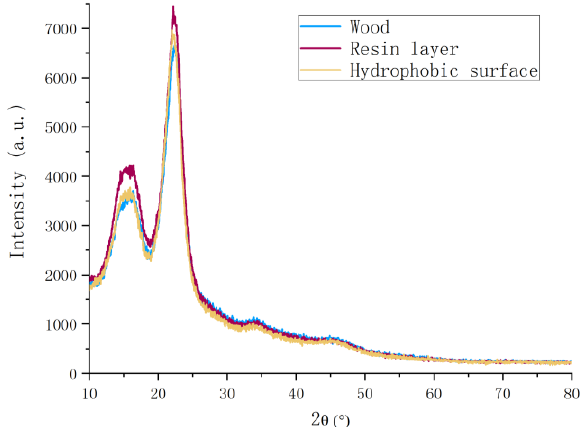
Figure 7. The infrared spectrum of the wood surface before and after treatment.